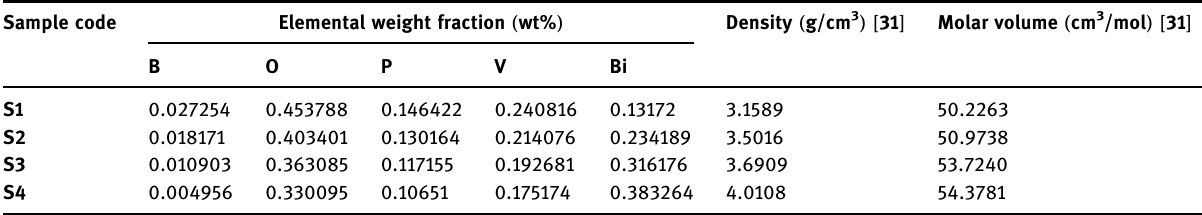
Table 1: Sample code, elemental weight fraction, density, and molar volume of ( 0.25 − x ) Bi 2 O 3 − x B 2 O 3 − 0.75 ( 50% P 2 O 5 − 50% V 2 O 5 ) , where x =